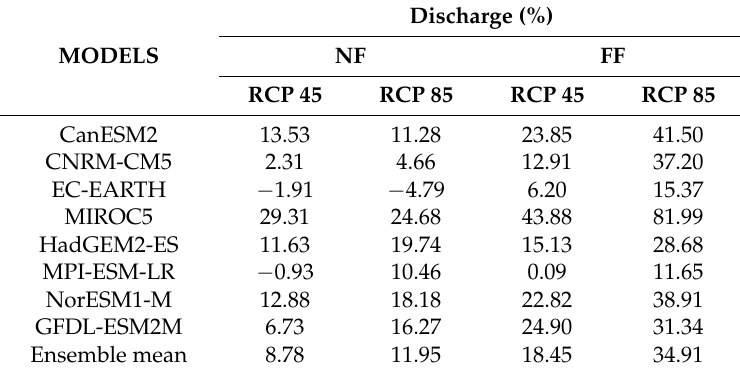
Table 4. Percentage discharge trends at the near future (NF, 2010–2035) and far future (FF, 2036–2100) relative to the historical